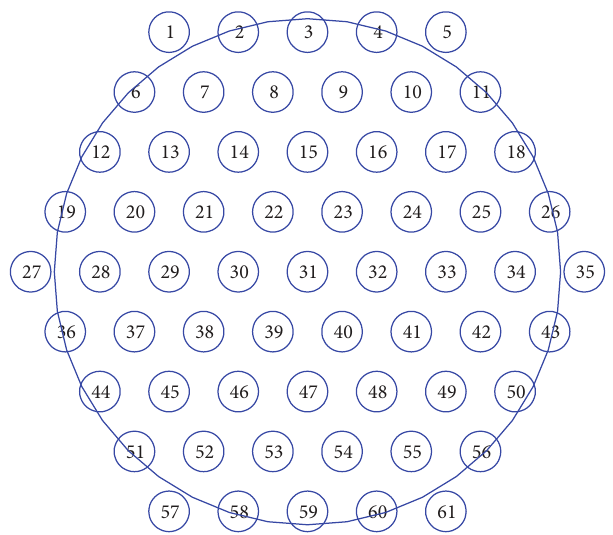
Figure 3: Actuators location of 61-element deformable